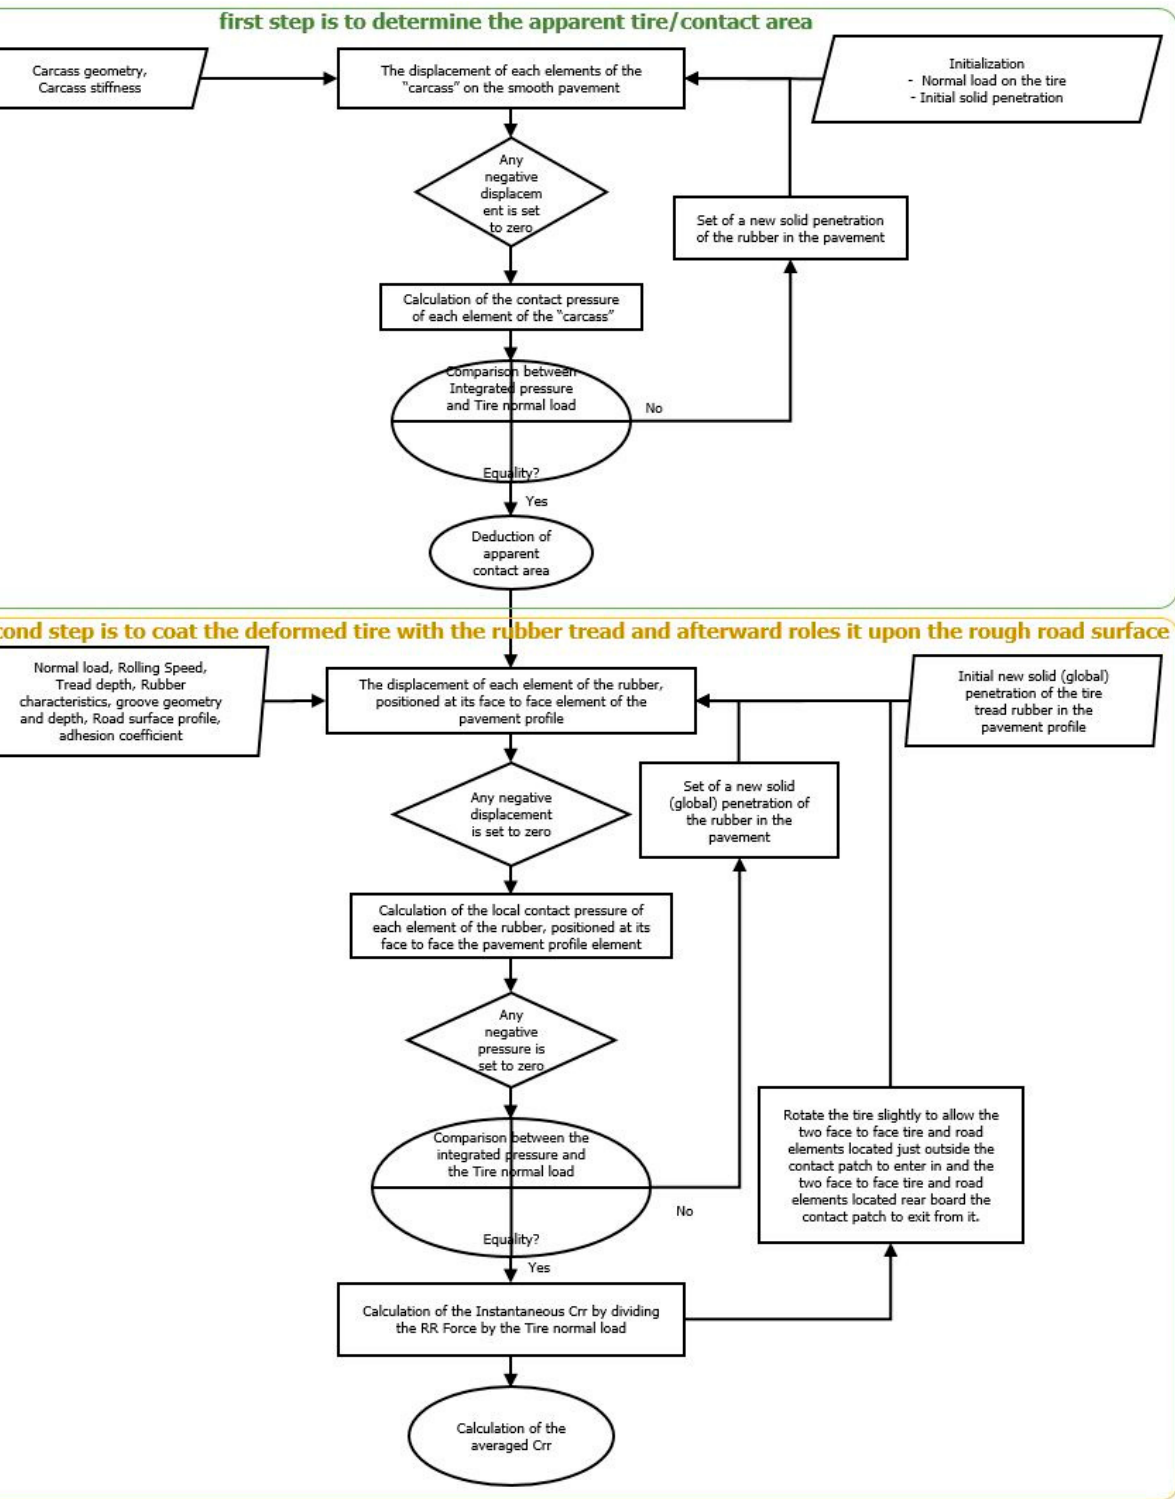
Figure 2. Algorithm of the Crr numerical calculation program.